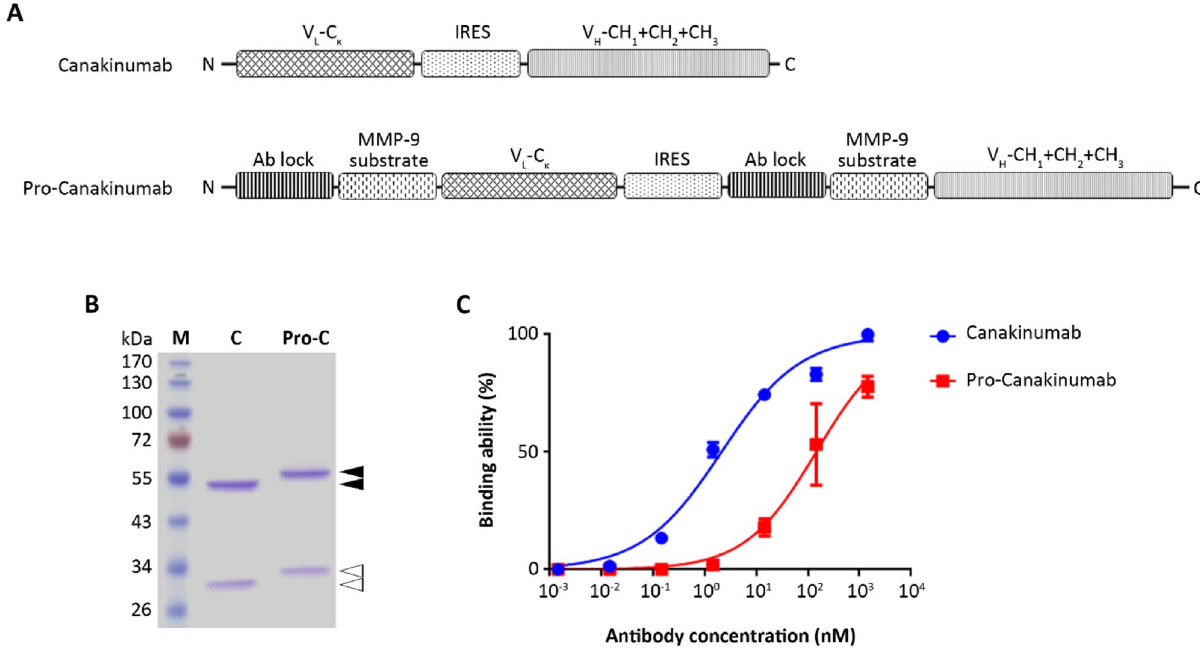
Figure 2. Generation and characterization of pro-Canakinumab. ( A ) Schematic of the Canakinumab (fully human anti-human IL-1β mAb) including (from the N to C terminus) the light chain (V L -C κ ) and heavy chain (V H -CH1 + CH2 + CH3) of Canakinumab that link with an internal ribosomal entry site (IRES). The pro- Canakinumab includes (from the N to C terminus) the IgG1 hinge (Ab lock) in front of the light chain (V L - C κ ) and heavy chain (V H -CH1 + CH2 + CH3) of Canakinumab, respectively, and these two fragments are also joined by an IRES. ( B ) SDS-PAGE analysis of protein A-purified Canakinumab and pro-Canakinumab: lane 1, molecular weight marker; lane 2, Canakinumab; lane 3, pro-Canakinumab. The black arrow indicates the heavy chain fragments of Canakinumab or pro-Canakinumab, respectively. The white arrow indicates the light chain fragments of Canakinumab or pro-Canakinumab, respectively. ( C ) The binding ability of Canakinumab (blue circles) and pro-Canakinumab (red squares) was assessed by IL-1β-based ELISA. The percentage of mean absorbance values (405 nm) of triplicate determinations are shown (n = 3). The bars indicate the